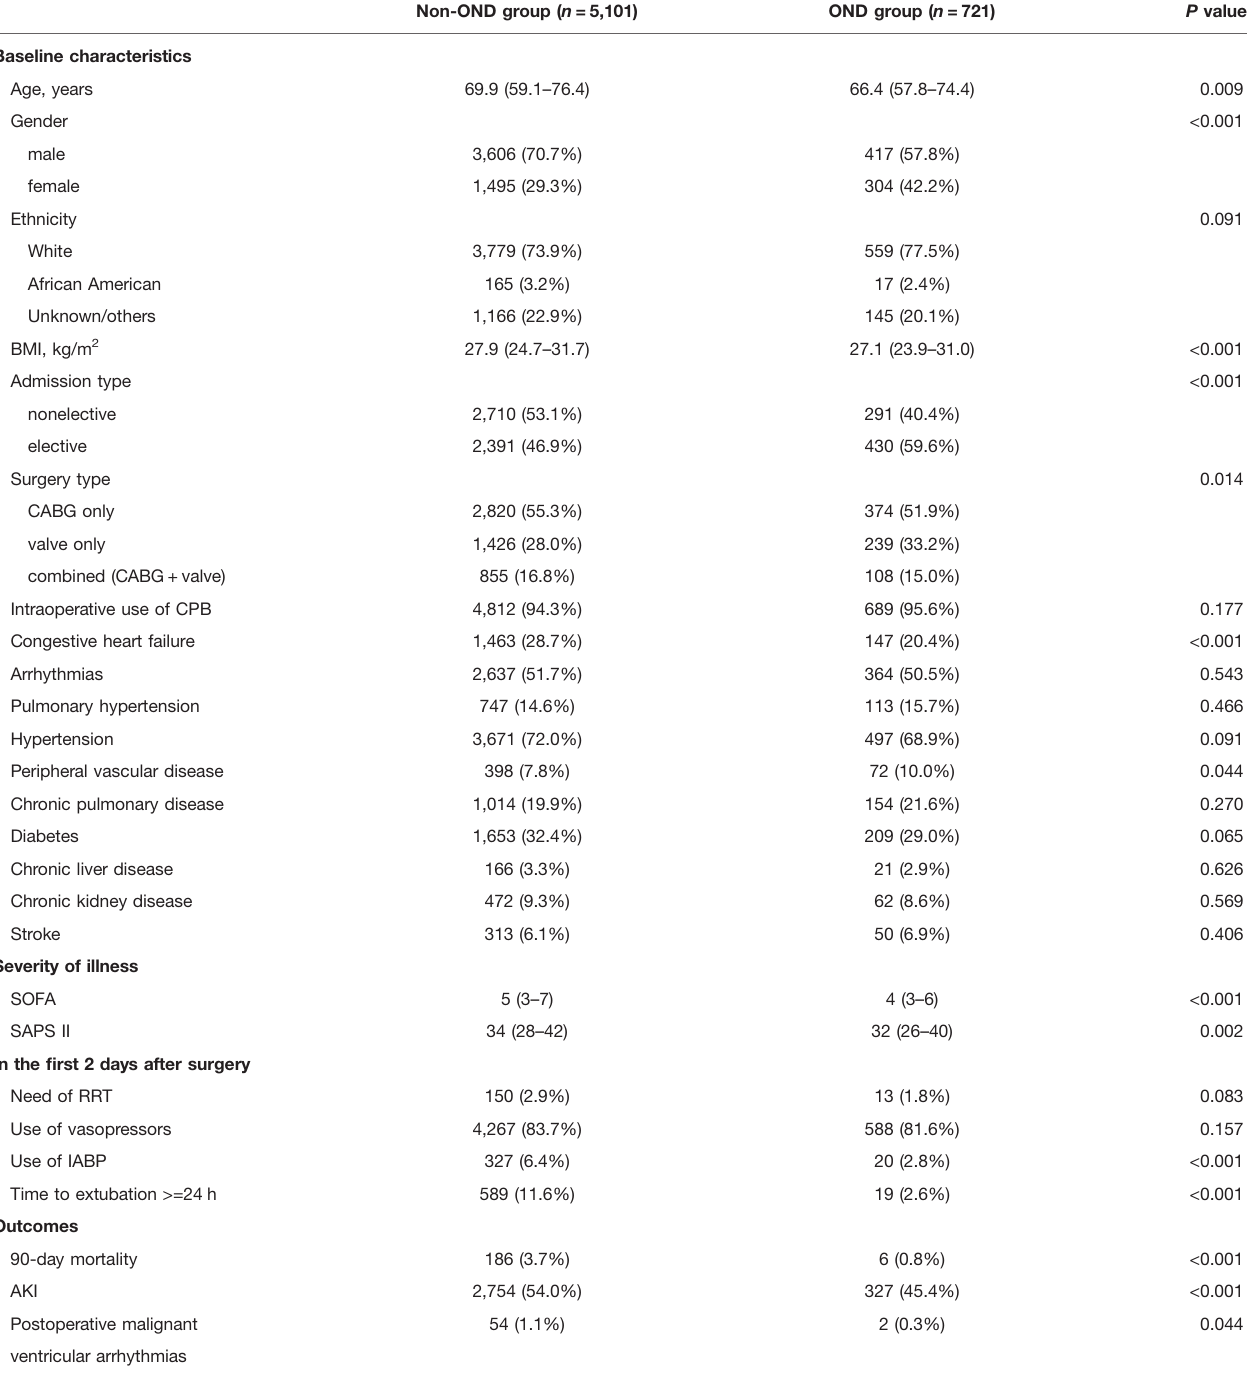
TABLE 1 | Characteristics and outcomes of the study population in the MIMIC – III database according to ondansetron